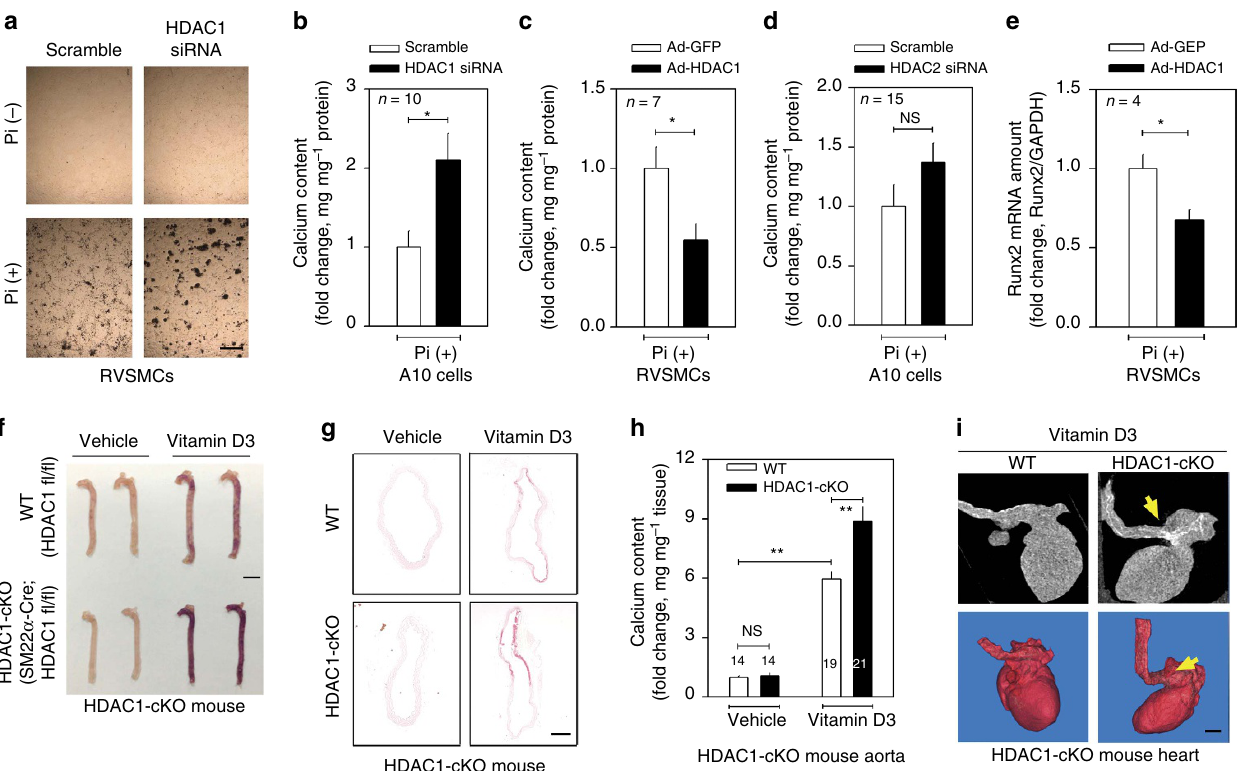
Figure 2 | Loss of HDAC1 enhances vascular calcification (VC). ( a ) Transfection of HDAC1 small interfering RNA (siRNA, 25nM) potentiated Pi-induced VC. Von Kossa staining. Scale bar, 100 m m. ( b ) Quantification results of calcium content in HDAC1 siRNA-transfected A10 cells. Ten samples from three independent sets were measured. ( c ) Infection of adenoviral HDAC1 (Ad-HDAC1) to RVSMCs blunted Pi-induced VC. RVSMCs were treated with Ad-HDAC1 (50 MOI), kept in serum-free condition for 24h and then switched to Pi-containing media. Cells were then treated with Ad-HDAC1 every 2 days ( n ¼ 7 from two sets). ( d ) Reduction of HDAC2 by HDAC2 siRNA (25nM) did not potentiate Pi-induced VC ( n ¼ 15 samples from three sets). ( e ) Ad-HDAC1 reduced Runx2 mRNA amount. Each sample was measured in duplicate and counted as one case ( n ¼ 4 from two sets). ( f ) Vascular smooth muscle cell-specific genetic ablation of HDAC1 ( SM22 a -cre ; HDAC1 fl/fl mice, HDAC 1-cKO) caused exaggeration of VC induced by administration of VD 3 in mice, compared with HDAC1 fl/fl control. VD 3 was administered to 6–8-week-old HDAC1 -cKO or HDAC1 fl/fl male mice. Alizarin red S staining. Scale bar, 3mm. ( g ) Horizontal sections of aorta showing VC in HDAC1 -cKO mice. Scale bar, 200 m m. ( h ) Quantification results of calcium deposition in HDAC1 -cKO mouse aorta. ( i ) Computed tomography (CT) images showing enhanced calcification in the arch of aorta. Arrows indicate the calcification foci at the proximal aorta and its branches. Upper panels: CT images. Lower panels: three-dimensional reconstruction images. Scale bar, 1mm. Error bars